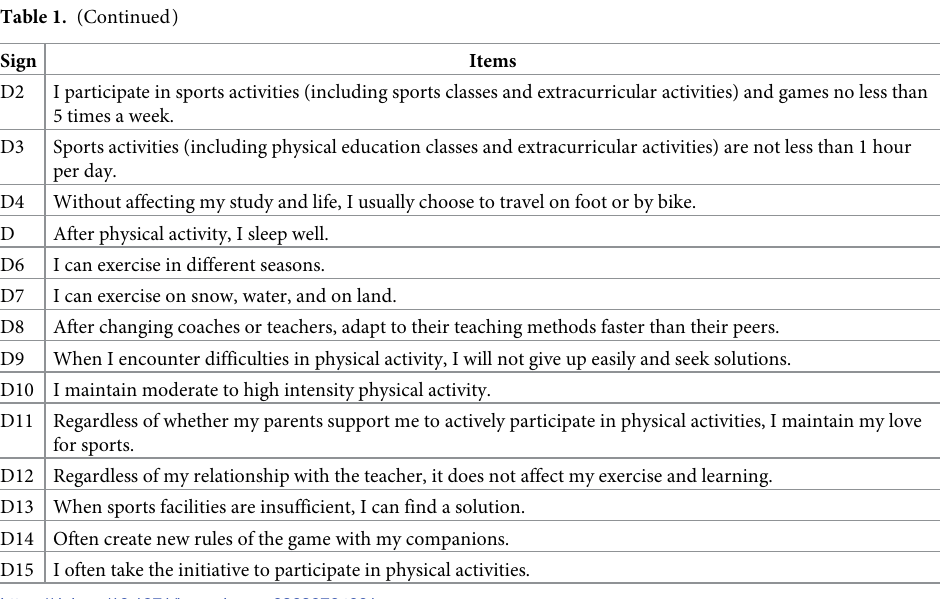
After confirming the validity of the data, researcher used IBM SPSS Statistics version 20 for Windows for the EFA analysis and IBM SPSS AMOS version 23 for Windows for the CFA analysis.